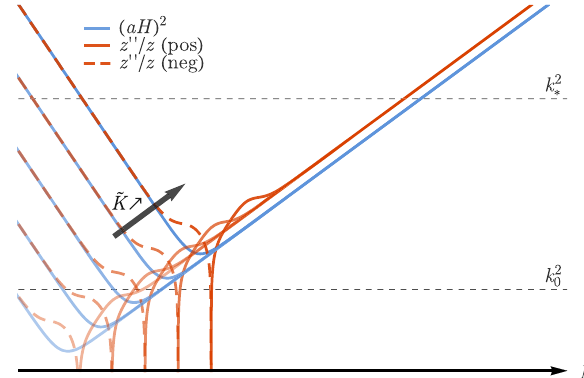
, is indicated by a dark dot. (Right Panel) inflation, when ( aH ) 2 = k 2 min As ˜ K increases the transition from decelerated expansion to power-law inflation affects higher wave-numbers. In order for any imprints of the transition to be visible on the primordial power spectrum the bumps of the potential z (cid:10)(cid:10) / z should be above k 2 , where k 0 corresponds to the 0 Hubble horizon at the present time. However, for the constraints on P R around the pivot scale k ∗ to be satisfied these bumps should be well below the k 2